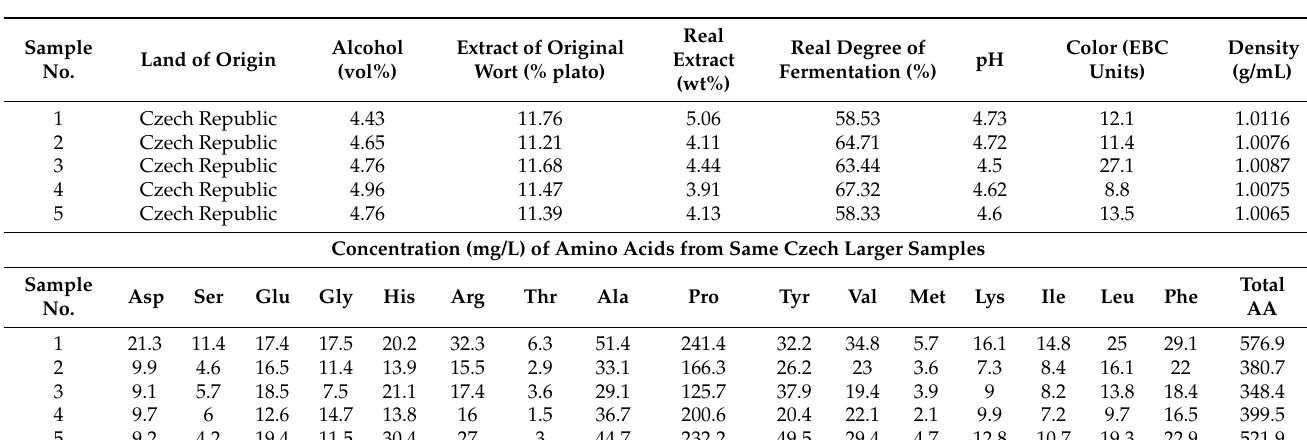
Table 9. Analysis of a variety of lager beer from the Czech Republic